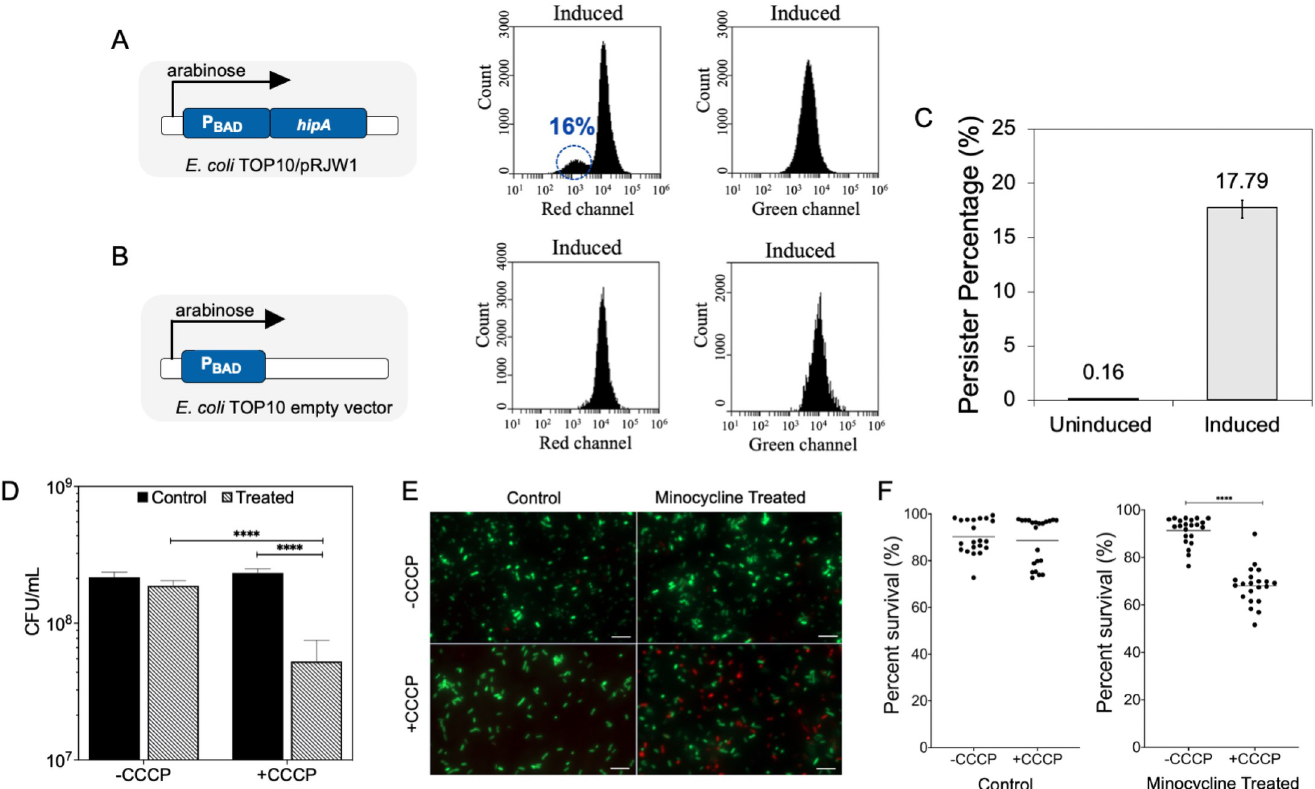
Fig 3. Persister formation led to lower membrane potential. (A, B) Schematic of hipA mediated persister formation by the P BAD protmoter. Flow cytometry analysis of JC-1 stained samples was used to compare the membrane potential of induced (with arabinose and tetracycline) E . coli Top10/pRJW1 (A) vs. induced E . coli Top10/pBAD (empty vector) (B) cells. A shift to low red fluorescence was observed for 16 ± 2.5% of induced cells of E . coli Top10/pRJW1, while no change was observed in green fluorescence. (C) Persister count increased when induced with both arabinose and tetracycline. (D) E . coli HM22 normal population was pretreated with CCCP (100 μ M) to reduce the membrane potential. The cells were then treated with 100 μ g/mL of minocycline. Means ± SE are shown (n = 3). (E) Representative fluorescent images of control and minocycline treated E . coli HM22 normal cells with or without CCCP pretreatment. The cells were labeled with SYTO9 and propodium iodide (PI) (scale bar, 10 μ M). (F) Cell viability based on mean fluorescence intensity quantified using Image J. Percentages are based on the ratios of green fluorescence vs. total fluorescence. � p -value � 0.05, �� p -value � 0.01, ��� p -value � 0.001, ���� p -value �